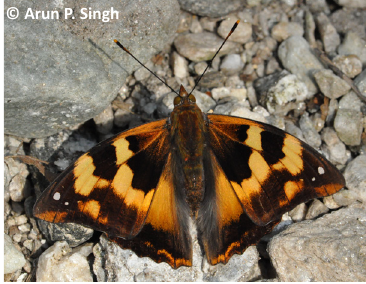
Image 25. Golden Emperor Dilipa morgiana— Kedarnath Musk Deer Reserve